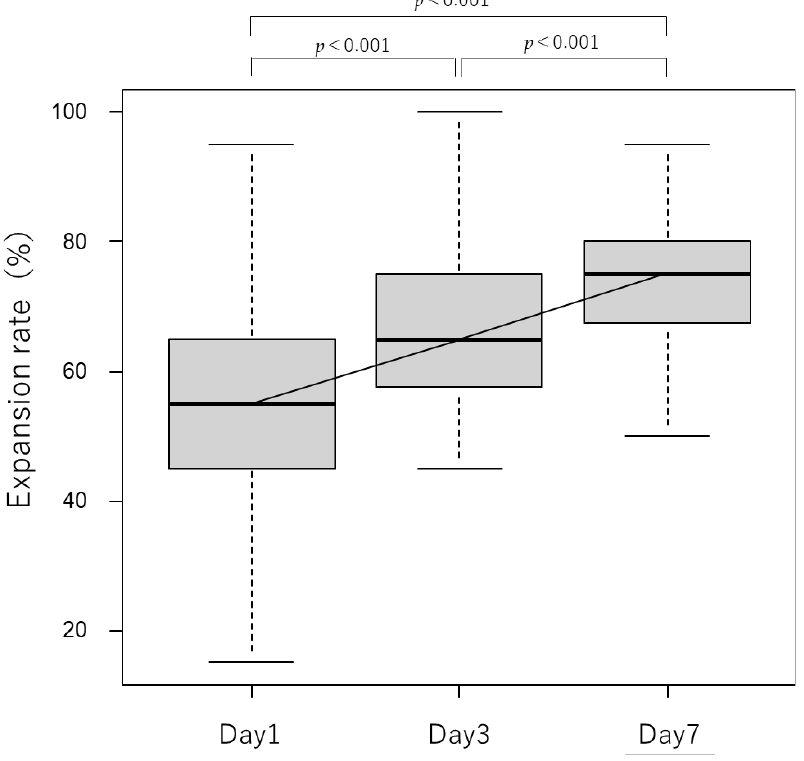
Figure 5. Transition of stent expansion rate. Stents were gradually expanded. Comparisons among three or more corresponding groups (Friedman test, p -value < 0.001) showed significant differences, and Bonferroni’s multiple comparison test also showed significant differences in each group.